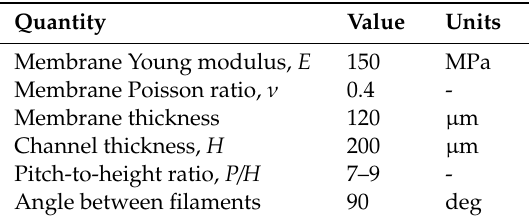
Table 2. Geometrical and mechanical